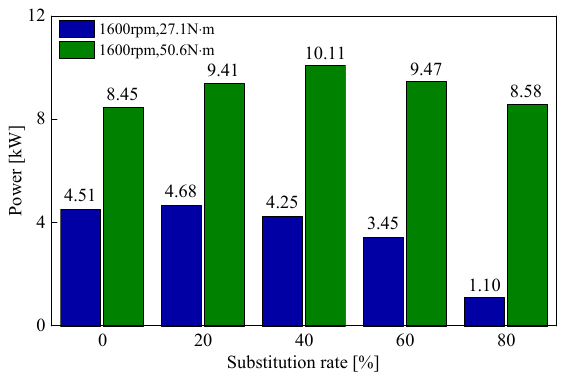
Figure 3. Power outputs with different substitution rate under throttled operation. Table 6. Indicated thermal efficiency at different conditions and substitution rate. Specification/Unit